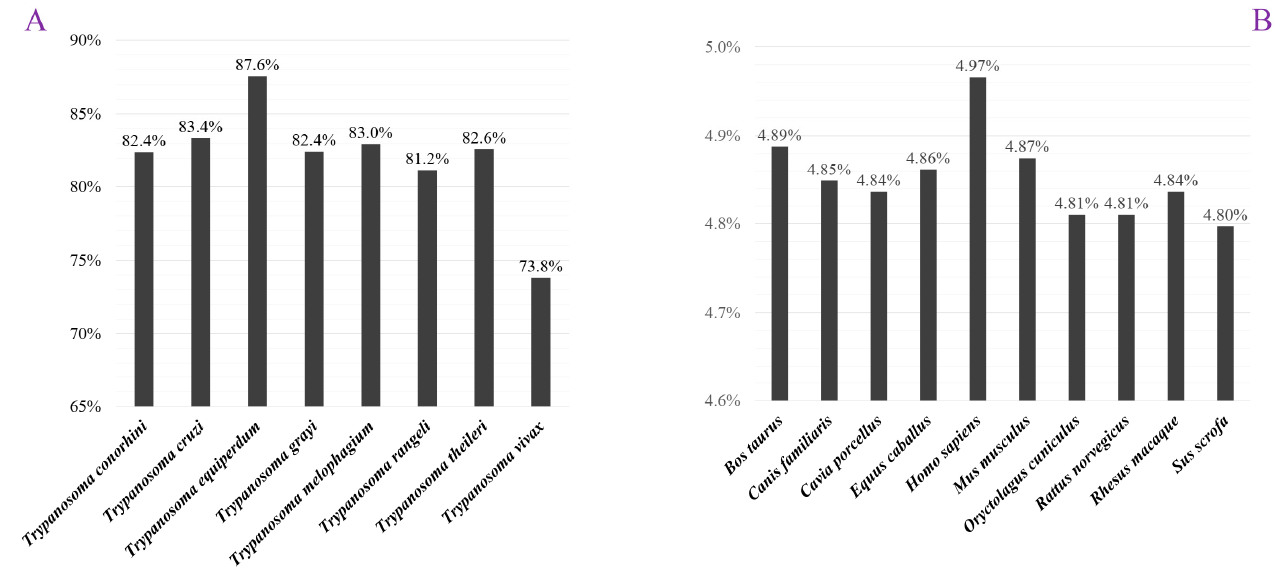
Figure 2. Homolog distribution of T. brucei proteins. ( A ) The homolog percentage of T. brucei when compared with other trypanosomes; ( B ) the homolog percentage of T. brucei when compared with other mammals.